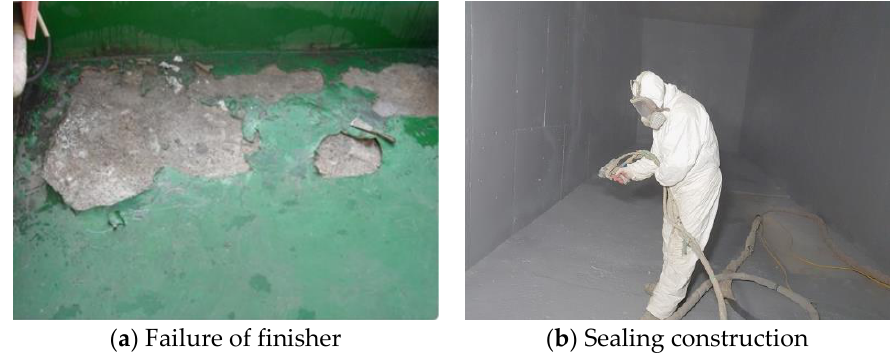
Figure 1. Structural and environmental issues of surface finishers.